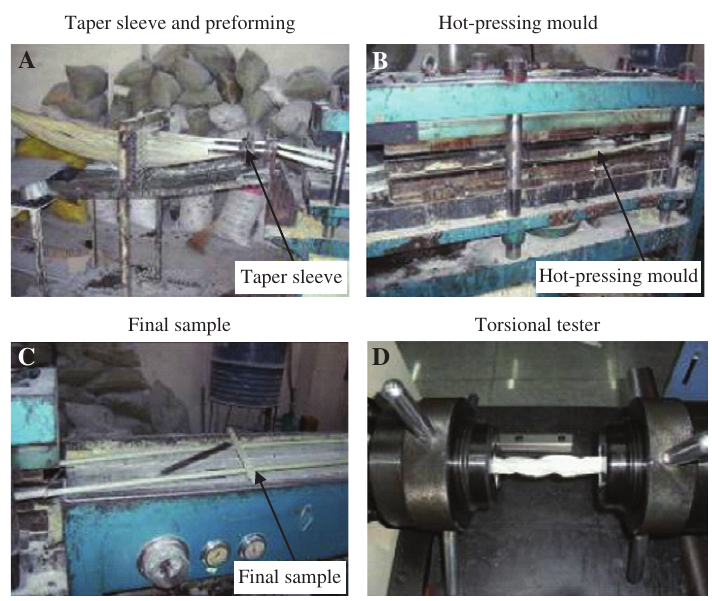
Figure 1 Schematic diagrams of samples forming process and torsional tester. (A) Taper sleeve and preformin. (B) Hot-pressing mould. (C) Final samples. (D) Torsional tester.